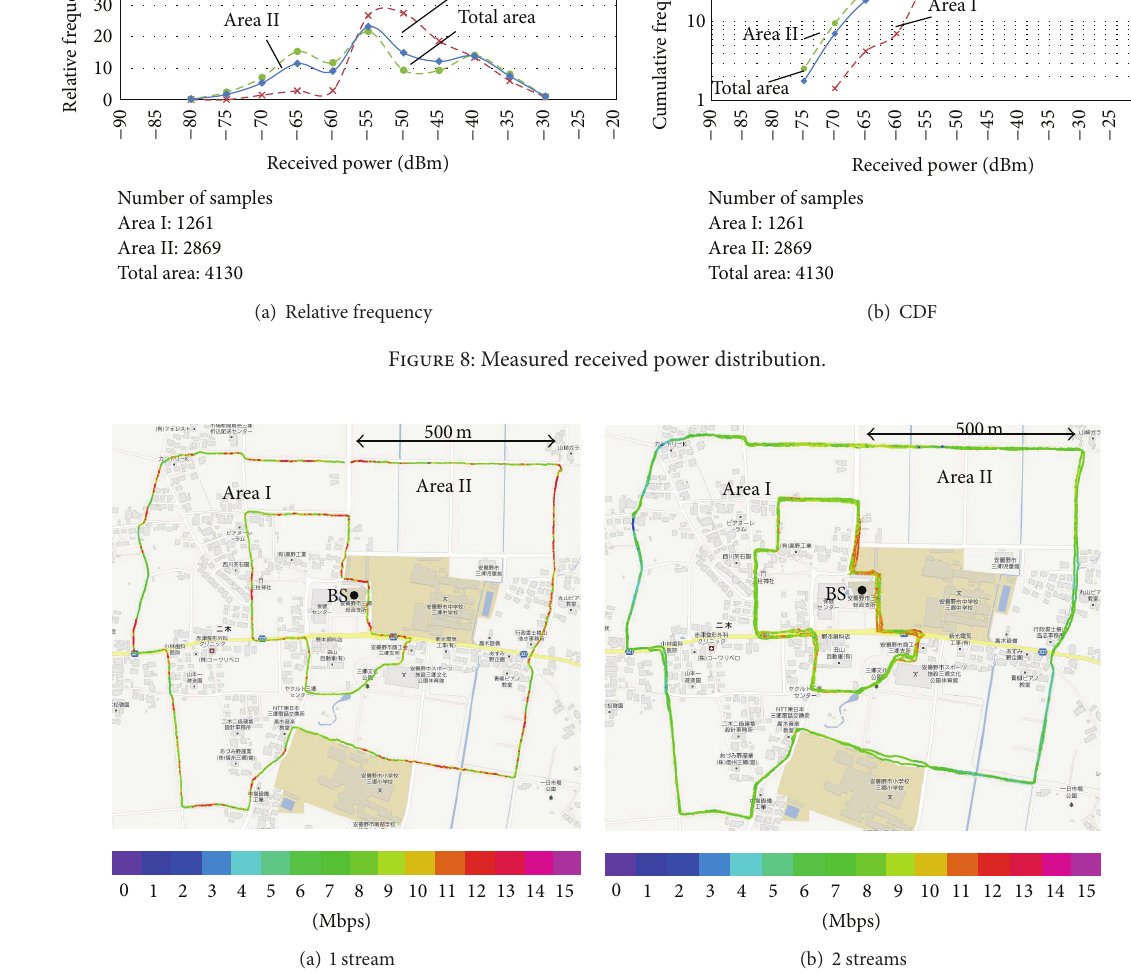
Figure 9: Route map and measured throughput at each